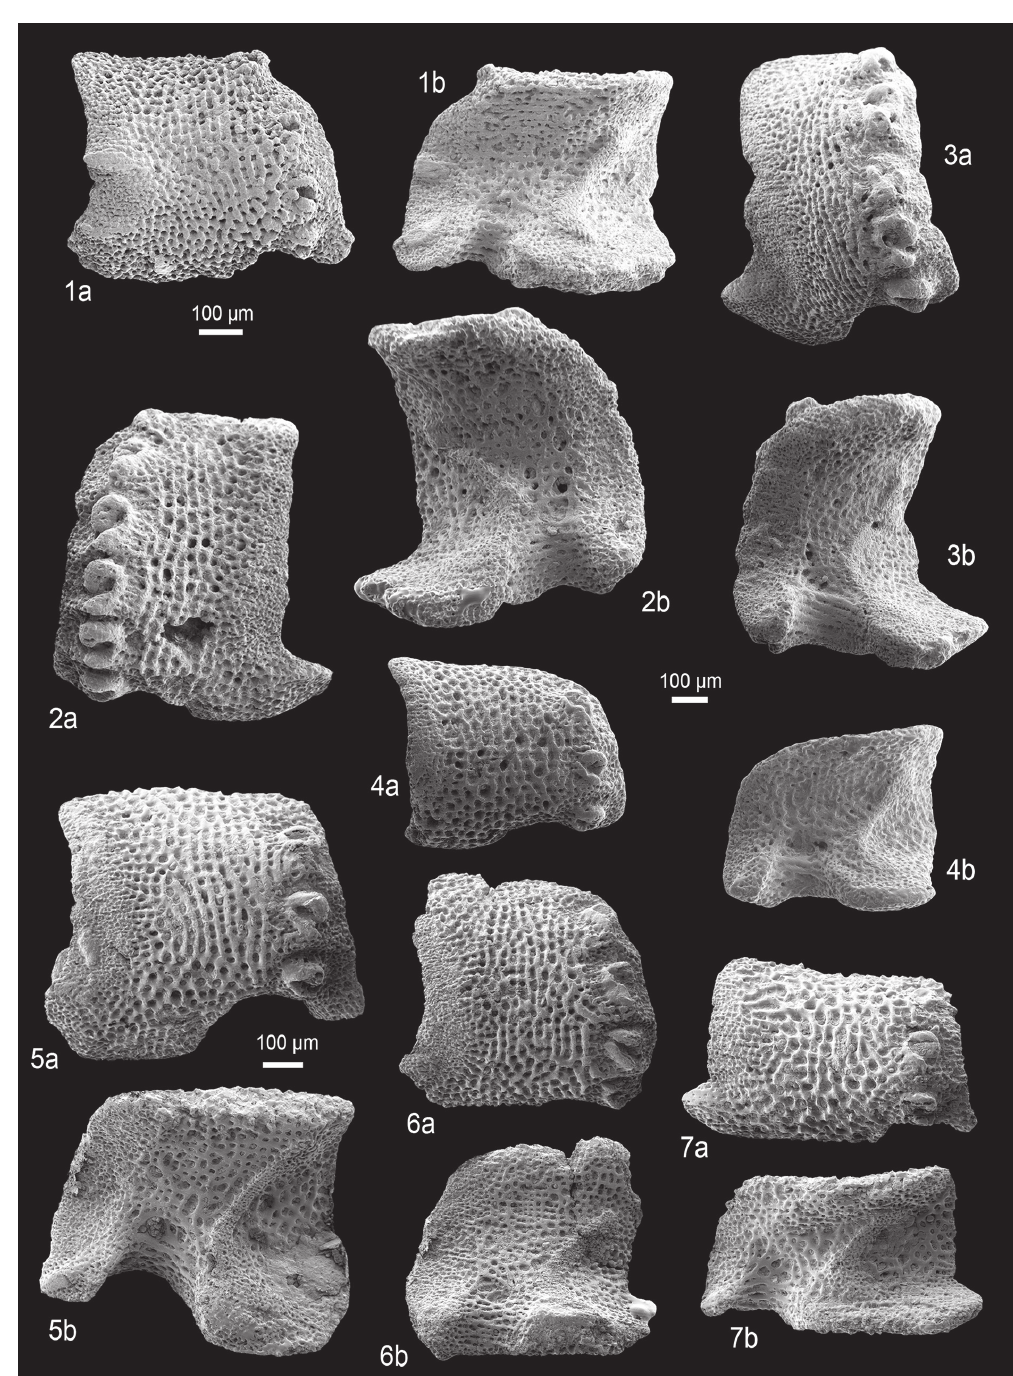
Fig. 8. Fossil lateral arm plates (LAPs) of ophiacanthid brittle stars in external (a) and internal (b) views. 1. Lapidaster sp. nov. innom. 1 from the late Toarcian (Early Jurassic) of Seewen, Switzerland; NHMB M11208, proximal to median LAP. 2-4. Lapidaster wolfii gen. et sp. nov. from the Bajocian-Bathonian boundary (Middle Jurassic) of Touert, France. 2. GZG.INV.78508 (holotype), proximal LAP. 3. GZG. INV.78509 (paratype), median LAP. 4. GZG.INV.78510 (paratype), distal LAP. 5-7. Lapidaster varuna gen. et sp. nov. from the Callovian of Jumara, India. 5. GZG.INV.78511 (holotype), proximal LAP. 6. GZG.INV.78512 (paratype), median LAP. 7. GZG.INV.78513 (paratype), distal LAP. One common scale bar per species is